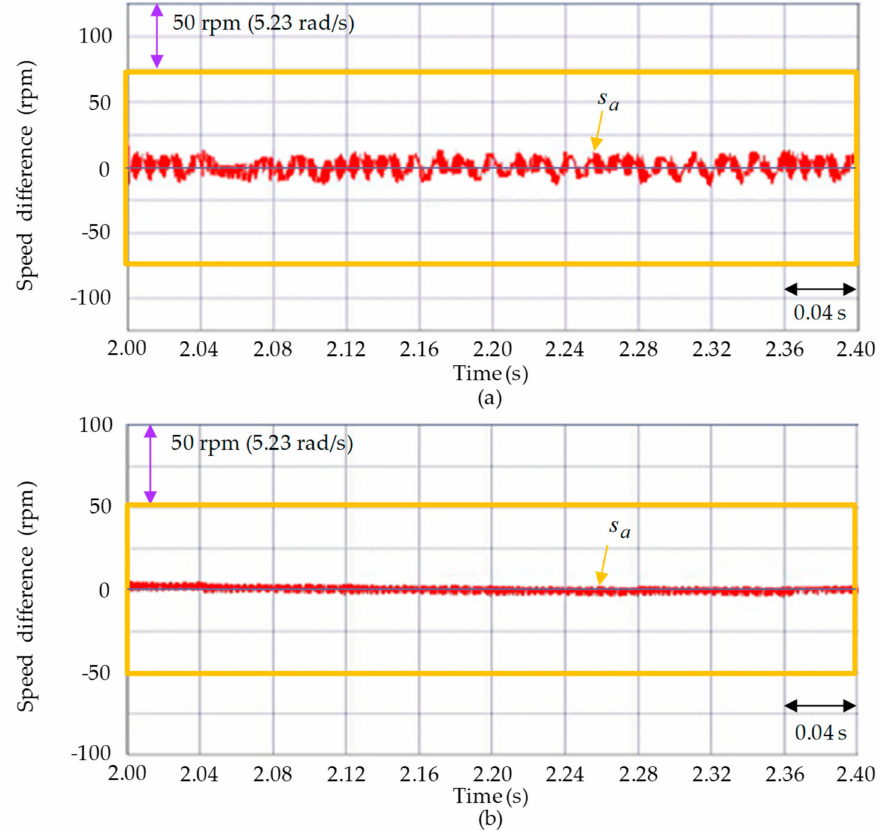
Figure 8. Increase in speed difference responses via experimental results for the ISM driving the rice milling machine system at test JA by adopting the controllers: ( a ) TA; ( b )